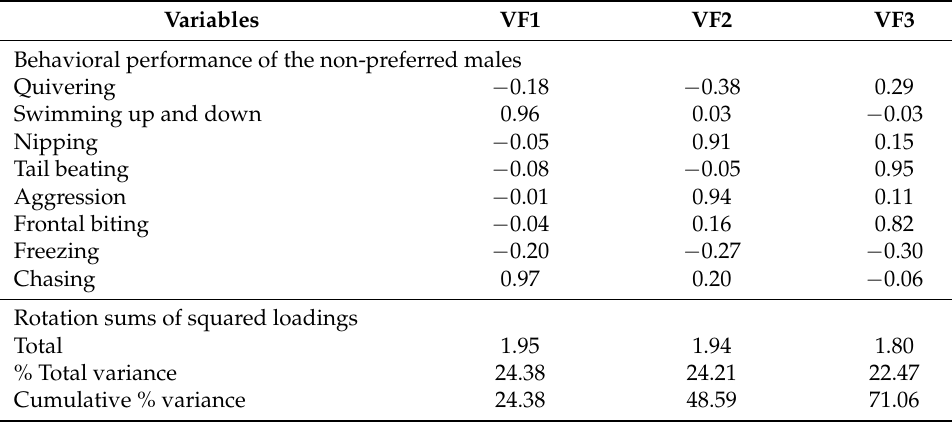
Table 6. PCA outcomes of non-preferred males in experiment 2.